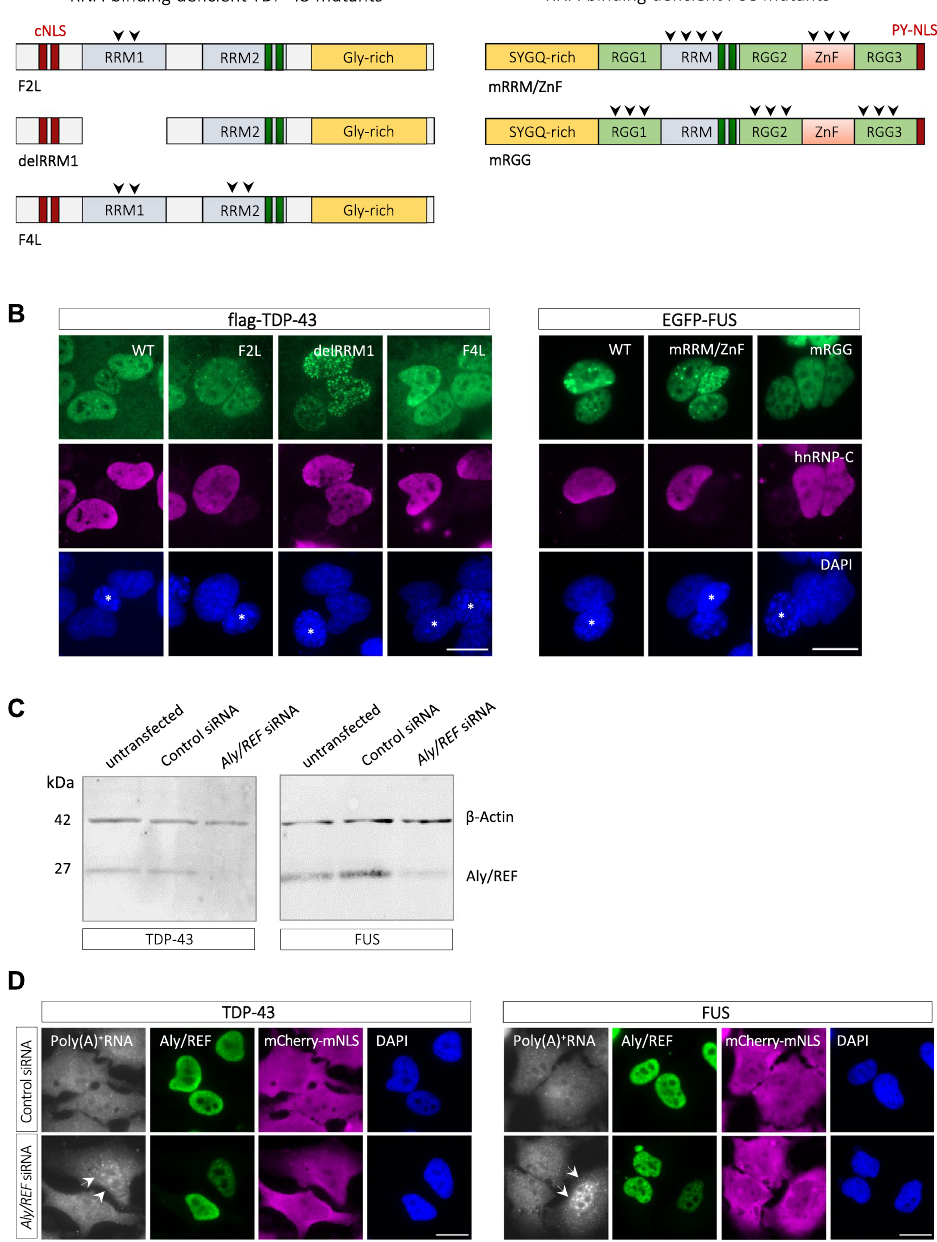
Figure 3. Nuclear export of TDP-43 and FUS does not require RNA-binding and is independent of the mRNA export machinery. ( A ) Schematic diagram of RNA-binding deficient TDP-43 and FUS mutants. 2FL = F147L/ F149L; 4FL = F147L/F149L/F229L/F231L; mRRM/mZnF = 7 point mutations in the RRM domain/6 point mutations in the zinc finger (see methods for details); mRGG = all Rs in RGG motifs were exchanged for K. ( B ) The indicated flag-tagged TDP-43 or EGFP-FUS constructs were transiently transfected into HeLa cells and nuclear export was examined in the interspecies heterokaryon assay. Heterokaryons were incubated for 2 h (TDP-43) and 3 h (FUS), respectively, in the presence of cycloheximide and localization of TDP-43 or FUS proteins were visualized by flag immunostaining or direct EGFP fluorescence (green), respectively, hnRNP-C immunostaining (magenta) and DAPI (blue). Both wild-type (WT) and RNA-binding deficient mutant versions of TDP-43 and FUS shuttle from human to mouse nuclei (marked with an asterisk in the DAPI channel). Scale bars: 20 μ m. ( C ) and ( D ) HeLa cells stably expressing mCherry-TDP-43-mNLS or mCherry-FUS-mNLS were transfected with control or Aly/REF -specific siRNA. 3 days post-transfection, Aly/REF levels in total cell lysates were analyzed by Western blotting, β -actin served as a loading control ( C ). In parallel, cells were processed for fluorescence in situ hybridization (FISH) and immunocytochemistry to visualize poly(A) + mRNA (white), Aly/REF (green), mCherry-TDP-43/FUS-mNLS (magenta) and were stained with DAPI (blue) ( D ). Cells with reduced Aly/REF levels show a nuclear accumulation of poly(A) + mRNA (arrows), however no nuclear accumulation of mCherry-tagged NLS mutant TDP-43 or FUS. Scale bars: 20 μ